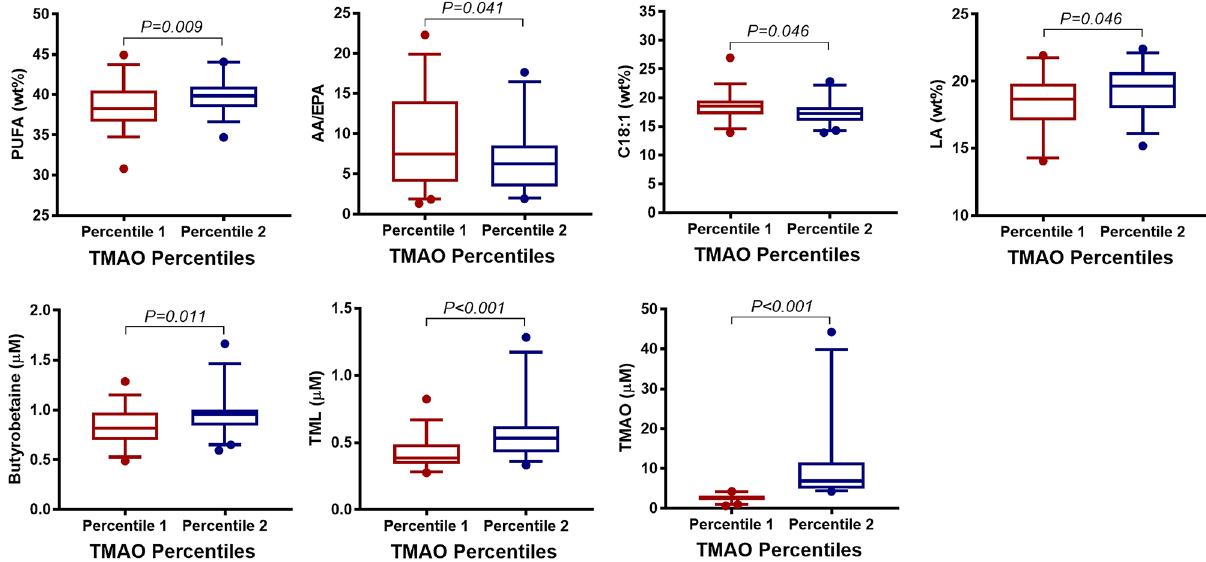
Figure 6. Association between whole blood FA, serum carnitine- and choline derivatives, and TMAO percentiles in RA patients (N = 78). Boxplots show FA and carnitine- and choline derivatives significant associated with TMAO percentiles, categorized into lowest TMAO percentile: percentile 1 (0.67–4.21 µM, N = 39, coloured in red) and highest TMAO percentile: percentile 2 (4.29–44.28 µM, N = 39, coloured in blue). The boxplots show medians, the error bars indicate 5–95% confidence interval. The connectors show statistically significant differences, P < 0.05. P -values are based on Student